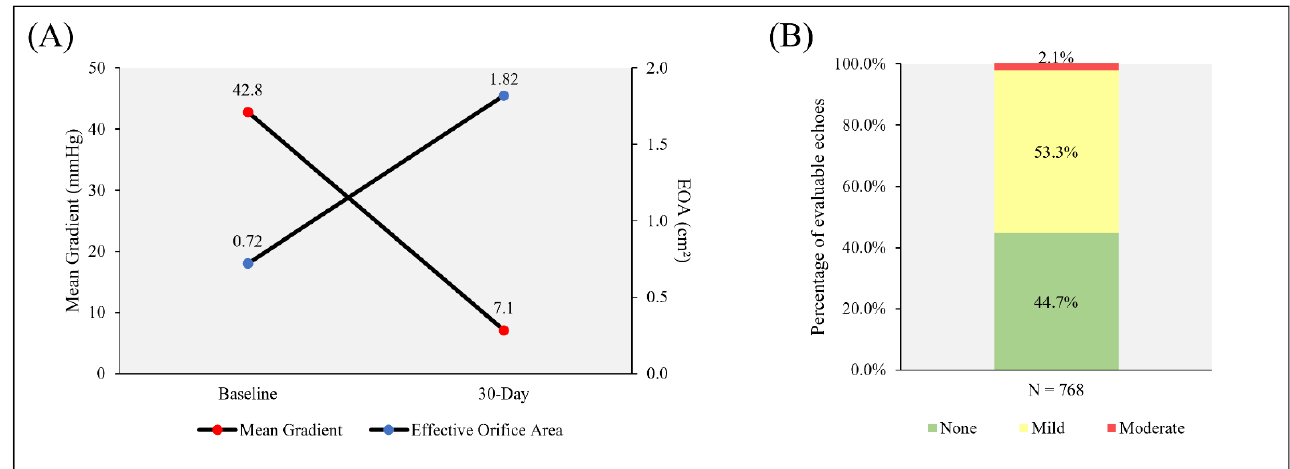
Figure 3. Valve hemodynamics: ( A ) effective orifice area (EOA) and mean gradient at baseline and 30 days; ( B ) severity of paravalvular leak at 30 days.